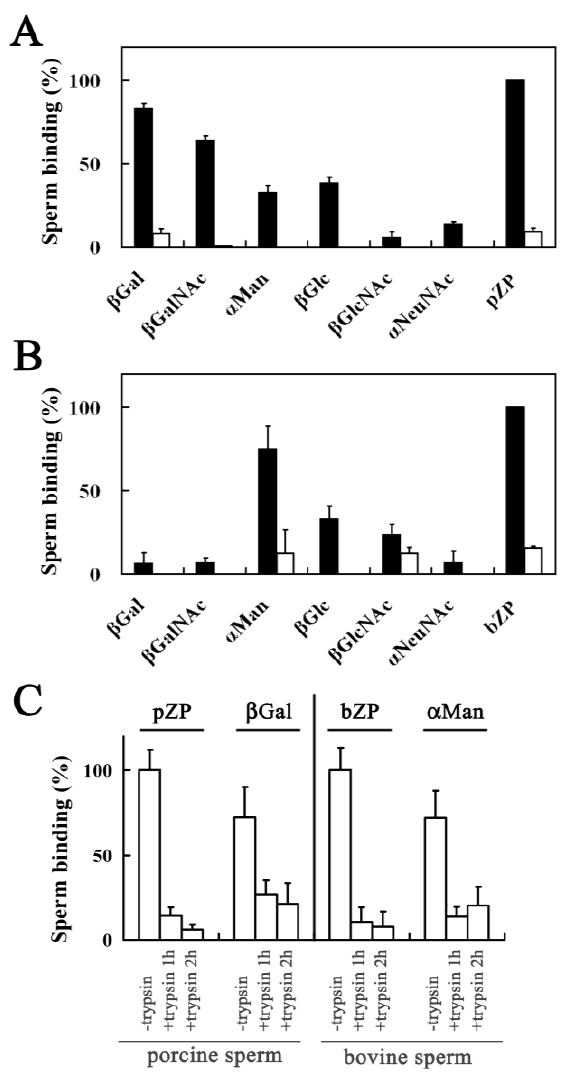
Figure 2. Sperm binding to plastic wells coated with glycolipid analogs and the zona protein (ZPG) mixture. The number of porcine sperm ( A ) and bovine sperm ( B ) bound to plastic wells was scored and expressed as a percentage of the number bound to the porcine ZPG mixture (pZP) in ( A ) and the bovine ZPG mixture (bZP) in ( B ), respectively. The mean number of sperm bound to the wells coated with pZP and bZP were 43 and 33, respectively, and were designated as 100%. The binding numbers of sperm not treated with the ZPG mixture were shown by solid bars. In the glycolipid analogs of βGal, βGalNAc, and pZP in ( A ) and that of αMan, βGlcNAc, and bZP in ( B ), the binding numbers of sperm treated with the respective ZPG mixture were also shown (open bars). Assays were repeated five times, and the data are shown as the mean ± SD. βGal, β-Gal-C6BDB; βGalNAc, β-GalNAc-C6BDB; αMan, α-Man-C6BDB; βGlc, β-Glc-C6BDB; βGlcNAc, β-GlcNAc-C6BDB; αNeuNAc, α-NeuNAc-C6BDB. (C) Effect of trypsinization of sperm for 1 or 2 h on the binding of porcine and bovine sperm to plastic wells. The number of trypsin-treated sperm that bound to the wells coated with pZP or β-Gal-C6BDB (βGal) and bZP or α-Man-C6BDB (αMan) were scored and expressed as a percentage of the number of sperm not treated with trypsin bound to their respective ZPG